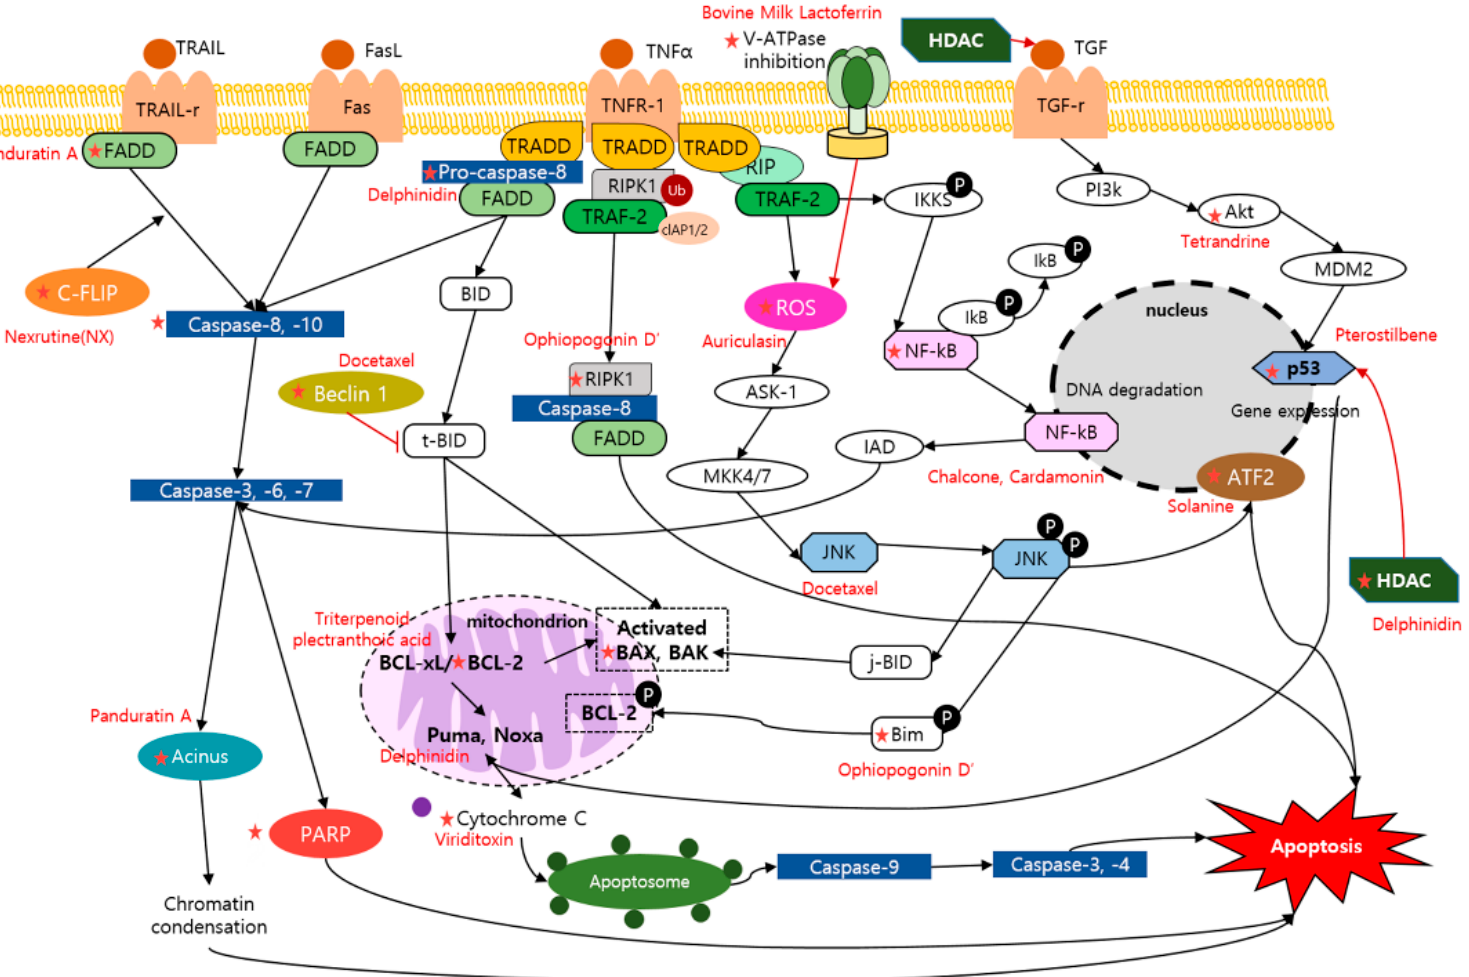
Figure 1. Schematic diagram of apoptotic mechanisms of dietary compounds. ★ , The molecule is regulated by the compounds.